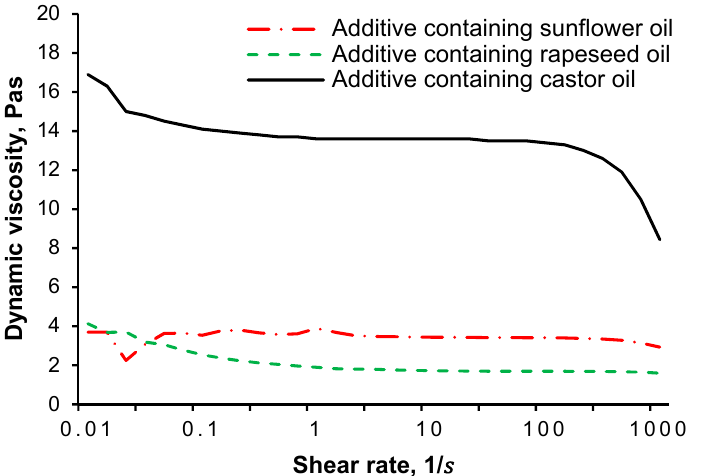
Figure 4. Rheological behaviour of synthesized additives in the range of 1–1000 1 Based on the dynamic viscosity values, it can be stated that the additives containing castor oil had the highest dynamic viscosity, followed by the additive containing sunflower oil, and rapeseed oil. On one hand, it was caused by the effect of the length of hydrocarbon side chain of each vegetable oil. On the other hand, differences in viscosities were caused by the fact that the main components in vegetable oils are different with different